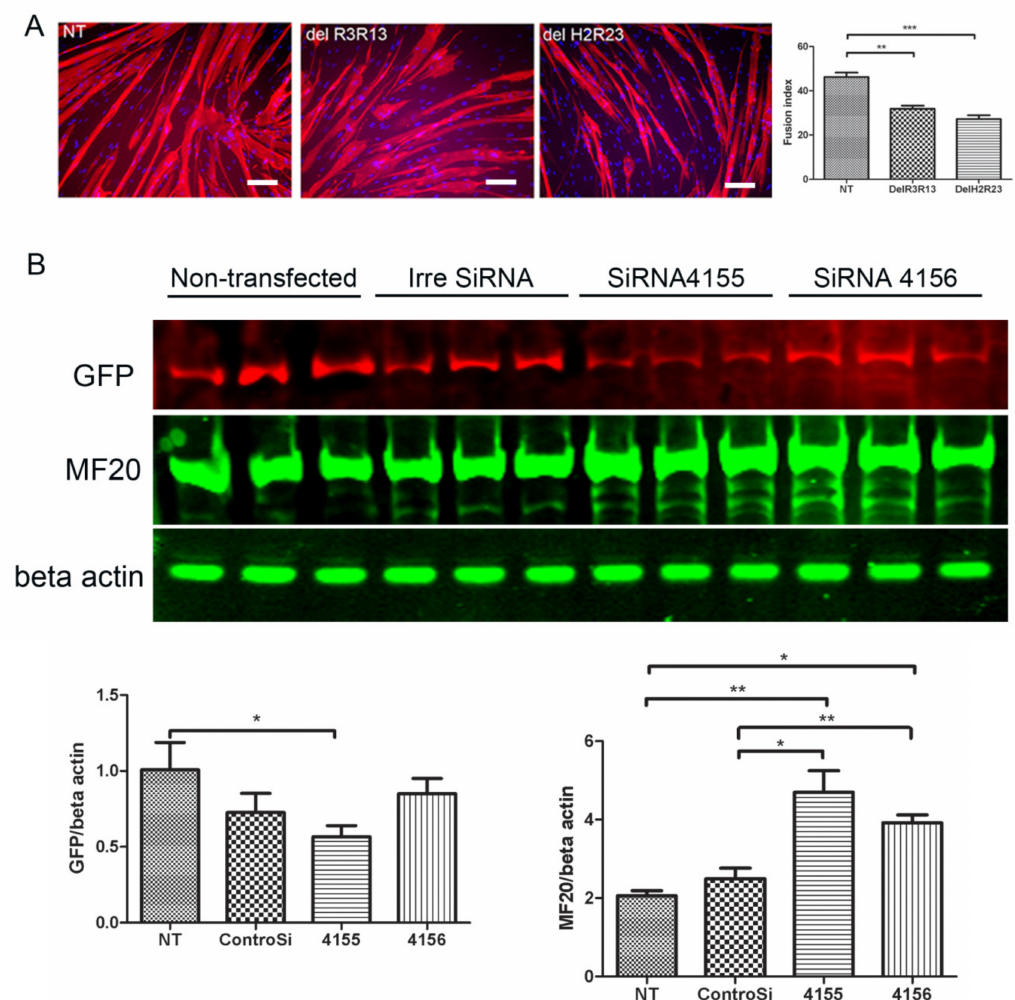
Figure 4. Mini-dystrophins reduce the terminal myogenic di ff erentiation of human Duchenne muscular dystrophy (DMD) muscle cells ( A ), and this is reversed by the knockdown of dystrophin expression using siRNAs ( B ). Mini-dystrophin GFP + cells were induced to undergo myogenic di ff erentiation for 7 days, and the fusion index (FI) of each experimental group showed that both ∆ R3R13–GFP and ∆ H2R23–GFP transduced cells have a reduced fusion index compared to non-transduced cells ( A ), scale bar = 25 µ m. To determine whether the e ff ect of mini-dystrophin on myogenic di ff erentiation is reversible, ∆ H2R23–GFP cells were transfected with one of the two di ff erent dystrophin siRNAs (4155 and 4156), and then induced to undergo myogenic di ff erentiation for 7 days. Western blot showed that after SiRNA transfection, the dystrophin ∆ H2R23–GFP expression was reduced and myosin heavy chain increased in cells transfected with siRNA 4155, but not in cells transfected with siRNA 4156, ( B ). NT: non-transfected SFFV– ∆ H2R23–GFP cells; ConSi, 4155, 4156: SFFV– ∆ H2R23–GFP cells transfected with control siRNA or dystrophin siRNAs 4155 or 4156, respectively. * p < 0.05; ** p <